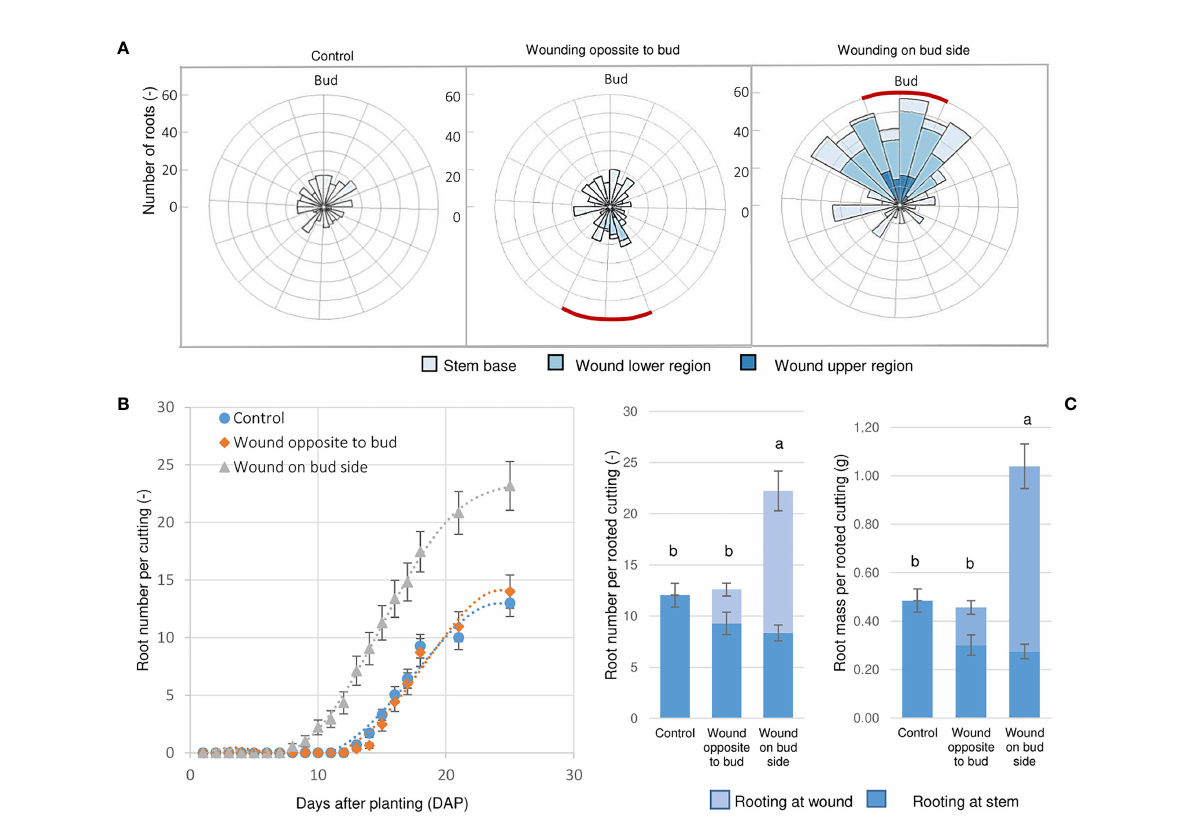
FIGURE 9 Wounding and bud position in fl uence AR formation. (A) Root spatial distribution of Rosa ‘ Tan09283 ’ cuttings when the sclerenchyma layer was reached applying a strip pattern on the side of the axillary bud and the opposite side in presence of 1 mg L -1 IBA. Red lines represent position of the laser strip treatment. (B) Dynamics of AR formation over time (days after planting) expressed as mean values with SE. (C) Root number and fresh mass distribution depending on the treatments. Columns represent the mean values and SE (n= 25). Columns that do not share a common letter represent signi fi cantly different levels (Tukey test, p ≤ 0.05); ns, non-signi fi